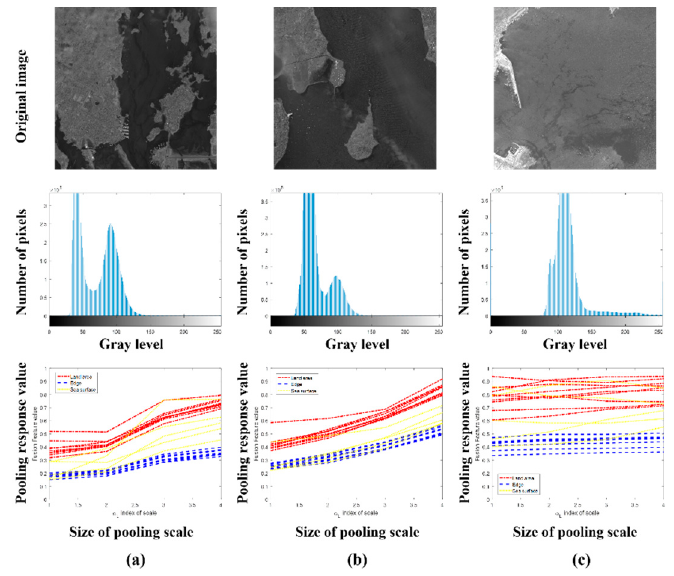
Figure 6. Discriminative feature description analysis of fusion feature multi-scale pooling for water and land area. ( a – c ) are original panchromatic images with their corresponding gray level histograms and fusion feature pooling response curve statistics.